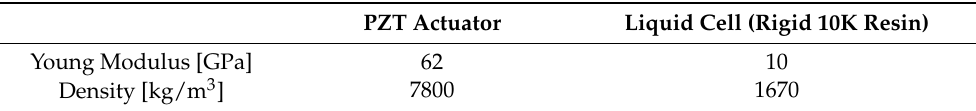
Table 2. Mechanical properties of the materials used in the simulation process.